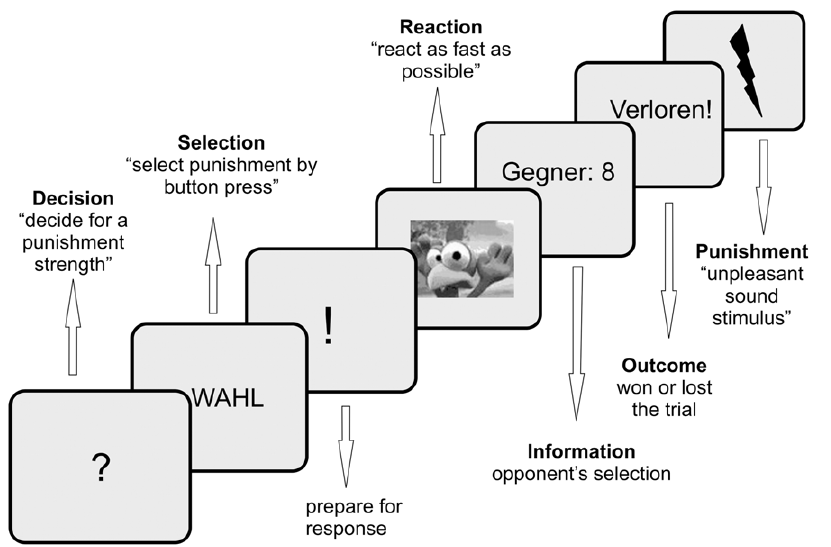
Figure 6. Experimental procedure. Participants were told that they are playing against another young man, who was introduced prior to the experiment. Trial structure: There was a Decision phase, a Selection Phase, a Reaction Phase and an Outcome phase in each trial. In the decision phase, participants selected the punishment (strength 1 to 8) which the opponent receives in case of losing the trial. Selection was followed by a ‘‘!’’ screen with variable interval between 600 and 800 ms. In the subsequent reaction phase, participants were instructed to respond as fast as possible to the appearance of a comic chicken. In the outcome phase, feedback was given whether the participant won (faster reaction to the chicken) or lost the trial. 40 trials constitute a block. There were alternating ‘‘passive’’ and ‘‘active’’ blocks. In ‘‘passive’’ blocks, the participant received an unpleasant sound stimulus at the end of the trial when they had a lower reaction time than the opponent, whereas the opponent did not receive a punishment when losing the trial. This pattern was reversed in the ‘‘active’’ blocks: The participant did not receive the punishment in case of loss, but the (virtual) opponent received the unpleasant sound stimulus; stimulus strength was determined by the participant in the decision phase. See text for further